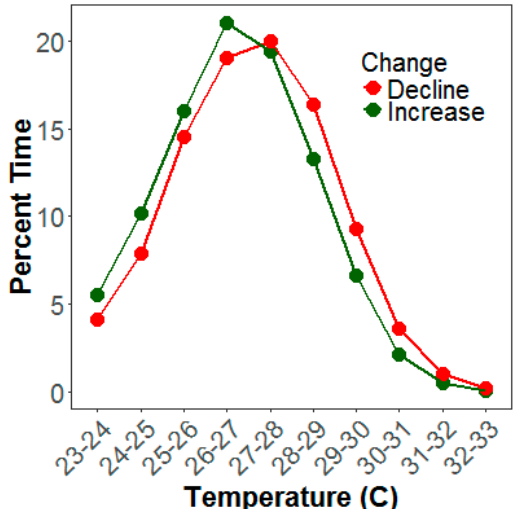
Figure 7. Percent time spent at each temperature bin for the summer period (June-August) comparing declining (red; 2001–2005 and 2009–2011), and increasing (green; 2006–2008 and 2012–2014) seagrass periods. Data are from the NERRS System-Wide Monitoring Program (SWMP) continuous monitoring station at Goodwin Island within the Mobjack Bay segment.